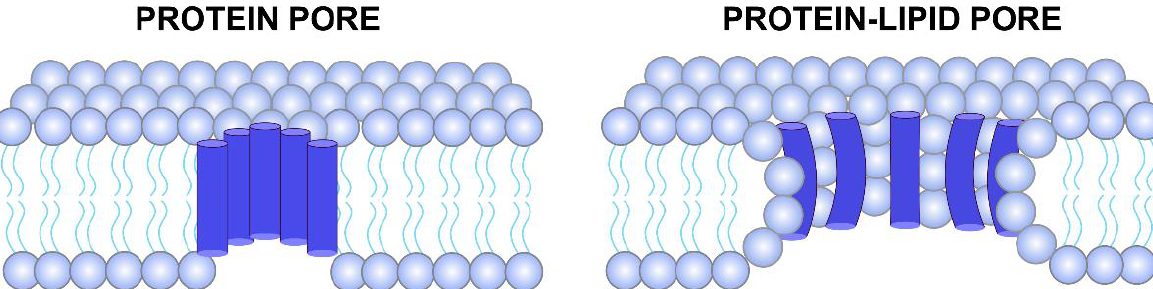
Figure 1. Ion channels formed by viroporins. Left depiction represents a channel exclusively formed by protein monomers (blue cylinders) inserted on a lipid membrane. Schematic on the right shows a protein-lipid pore. In this latter case, the lipid head groups (cyan circles) are oriented towards the channel pore, modulating ion conductance and selectivity.